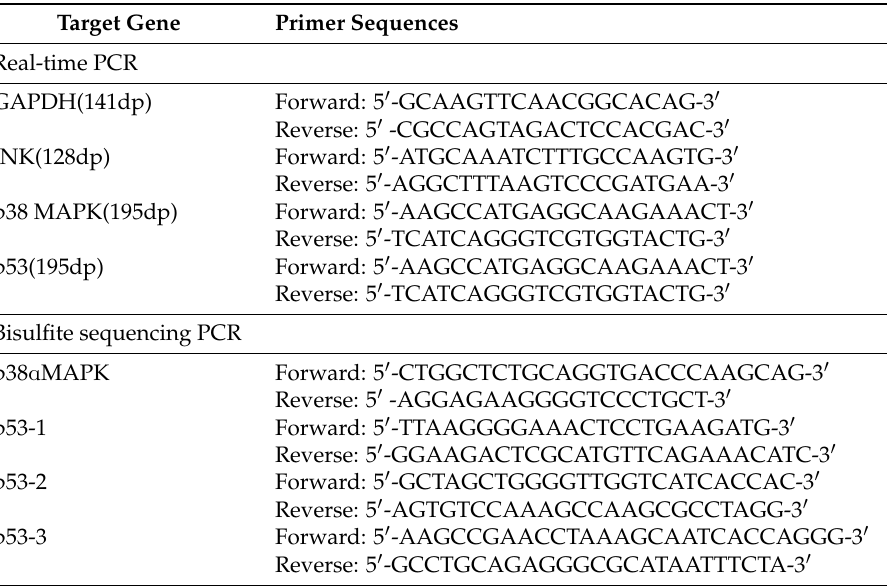
Table 1. Gene primer sequences for